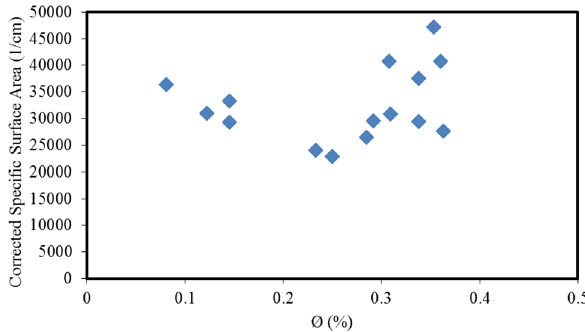
Fig. 10 Corrected specific surface area by calibration curve versus